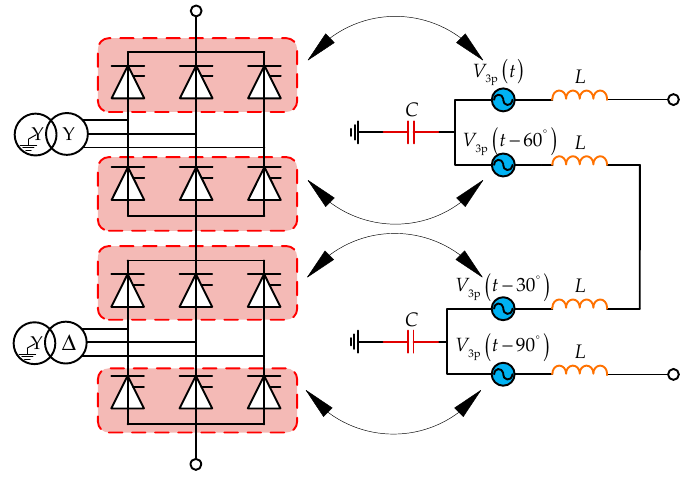
Figure 3. Three-pulse harmonic voltage source model of a twelve-pulse bridge.